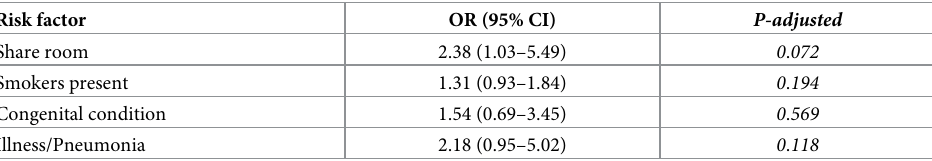
Table 3. Multivariable analysis for pneumococcal colonization risk factors among children (n = 245). Risk factor OR (95%